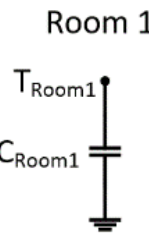
Figure 3. Defining the zones of the model.